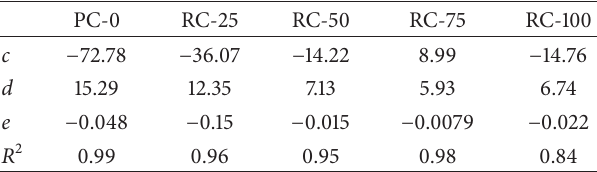
Table 5: Parameters in (5) for RAC